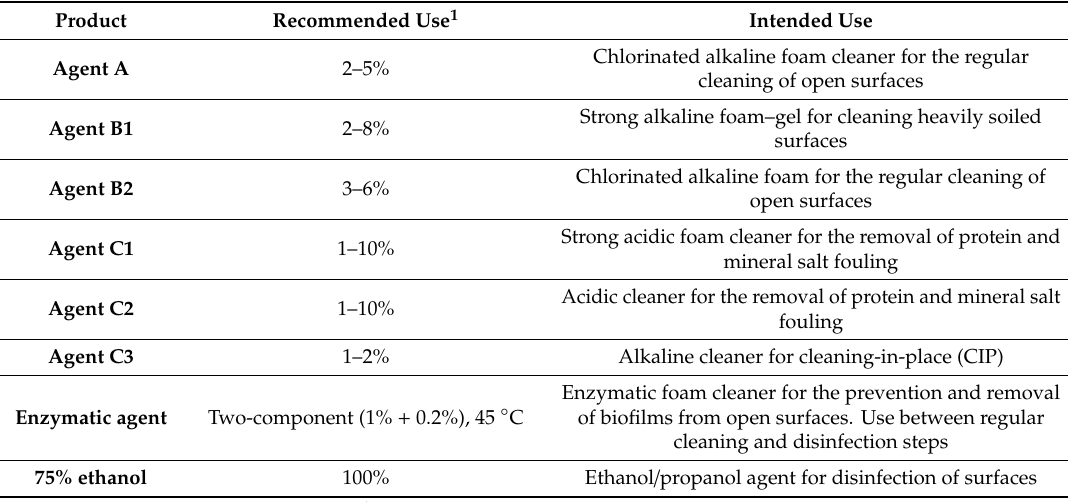
Table 1. Cleaning agents used in the current